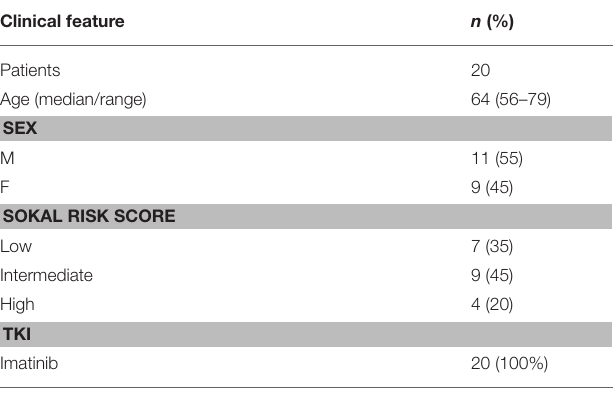
TABLE 1 | Clinical characteristics on the 20 patients enrolled into the study. Clinical